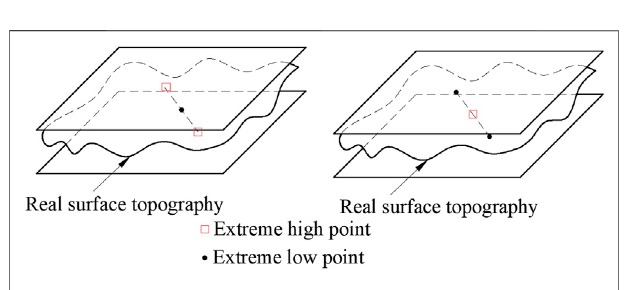
FIGURE 10 | Linear criteria.